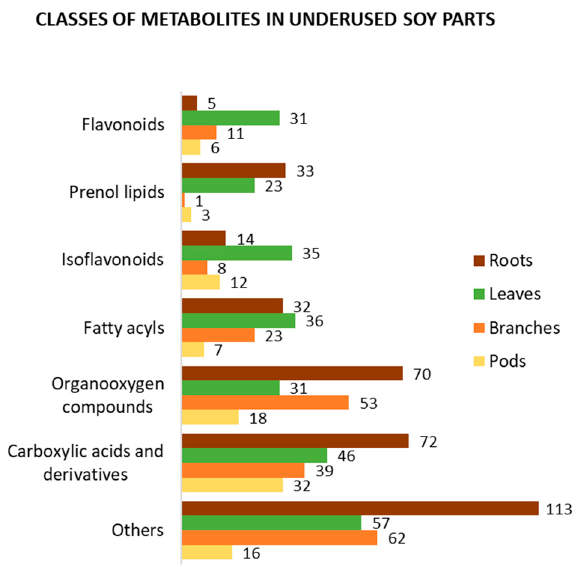
Figure 4. Classification of the metabolites identified in soy roots, leaves, branches, and pods according to ClassyFire.